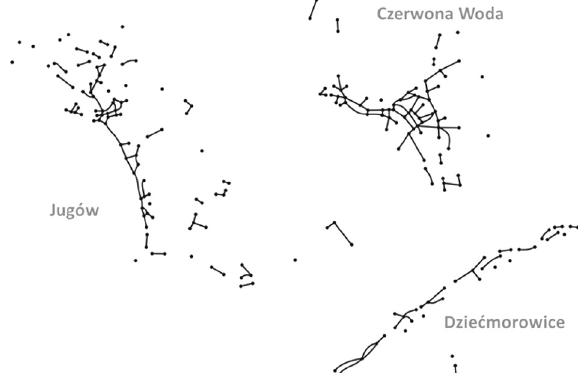
Fig. 15. Graphs depicting the morphology of mountain villages (MV1-MV6). Source: own work.